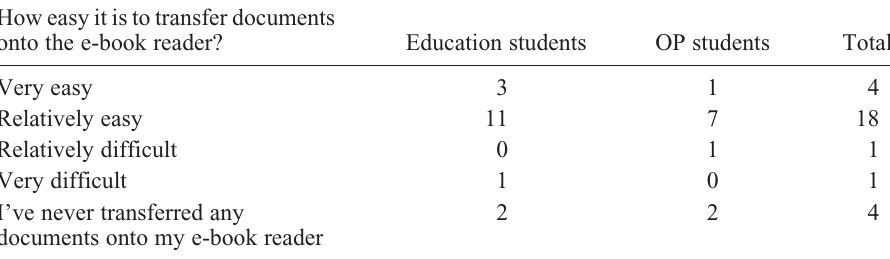
Table 10. How easy it is to transfer documents onto the e-book reader? How easy it is to transfer documents onto the e-book